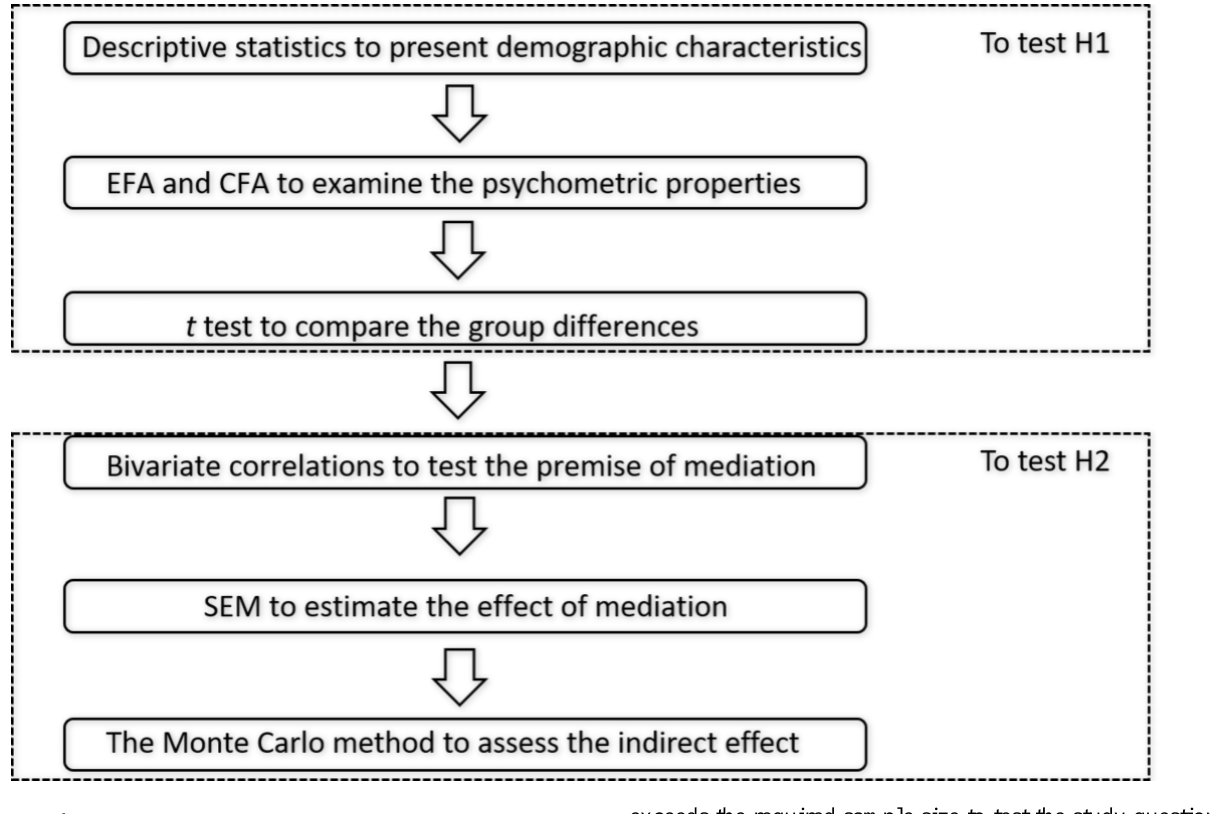
Figure 1. The flowchart for data analyses. CFA: confirmatory factor analysis; EFA: exploratory factor analysis; SEM: structural equation modeling; H1: hypothesis 1; H2: hypothesis